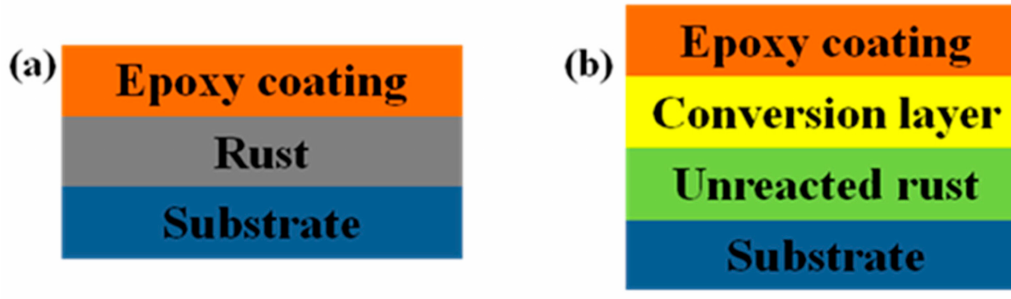
Figure 6. Structure models for: ( a ) before and ( b ) after rust converter treated steel